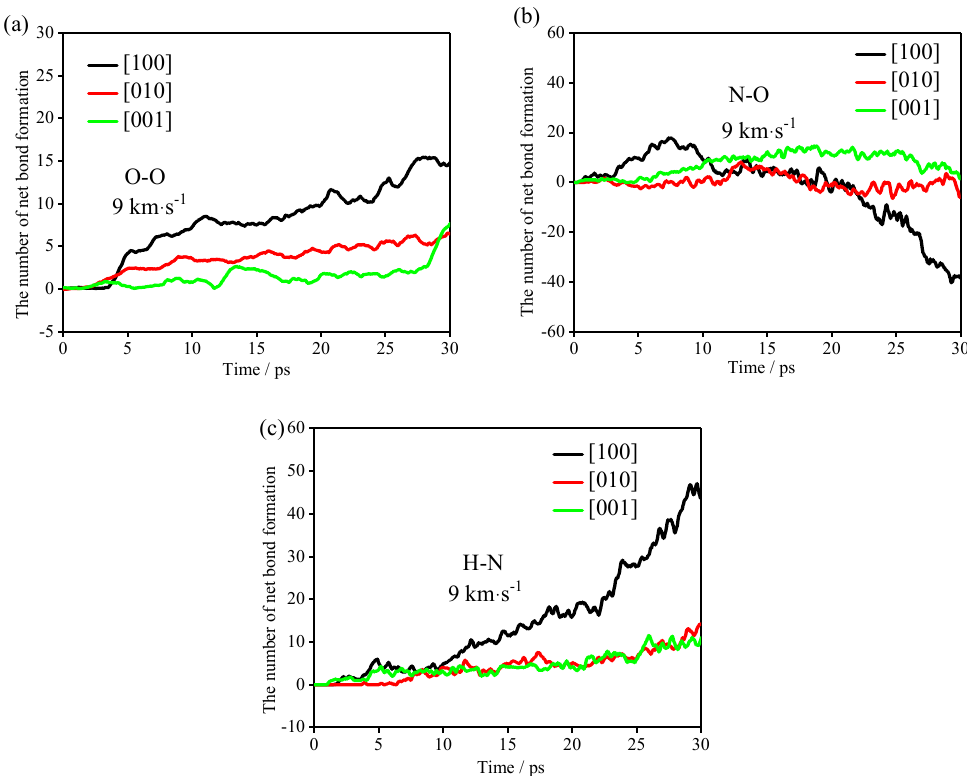
Figure 8. Net bonding of ( a ) O-O bonds, ( b ) N-O bonds and ( c ) H-N bonds. It can be seen from Table 4 that the polymerization of the TNAZ system frequently occurs before 10 ps. Therefore, in the first 10 ps reactions, the TNAZ molecules in the [100] shock direction are mainly combined into clusters by the formation of O-O, N-O and H- N bonds. The TNAZ molecules in the [010] shock direction are mainly combined into clus- ters by the formation of H-N bonds. The TNAZ molecules in the [001] shock direction are mainly combined into clusters by the formation of O-O bonds. In the formation of O-O and H-N bonds, the net bonding rate is the fastest in the [100] shock direction. Although the net bonding of O-O and H-N bonds in the [010] and [001] shock directions also show differences, the difference is not significant. Compared with the change trend of O-O and H-N bonds in the three directions, the change trend of the N-O bonds in the three direc- tions is obviously different. In the [100] shock direction, the N-O bonds form first and then break. In the [010] and [001] shock directions, the trend of net bond formation is not obvi- ous, and almost all of them show net bond breaking. This phenomenon may be related to the shock direction. In the [100] direction, the number of N-O bonds has an upward peak during the first 5–10 ps. This is due to the close distance between the N and O atoms in adjacent TNAZ molecules in the [100] direction. Shock wave compression makes the dis- tance between the N and O atoms shorter than the cut-off radius, resulting in an increase in the number of N-O bonds.